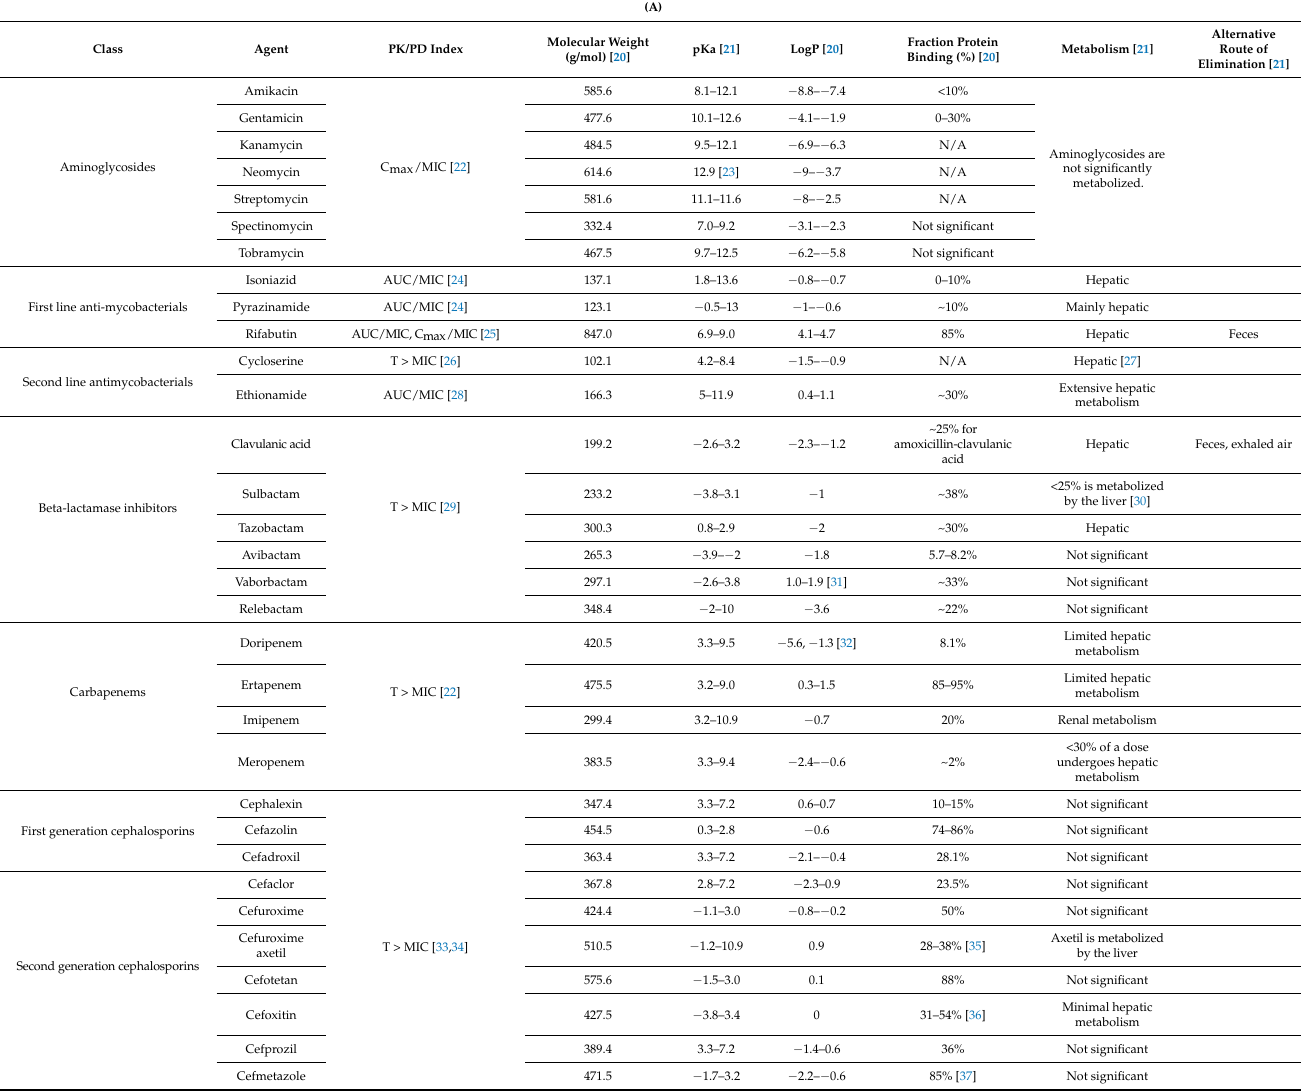
Table 1. (A) Physicochemical & pharmacokinetic characteristics of antimicrobials mainly eliminated by urine. (B) Physicochemical and pharmacokinetic characteristics of antimicrobials mainly elimi- nated by feces. (C) Physicochemical and pharmacokinetic characteristics of antimicrobials mainly eliminated by